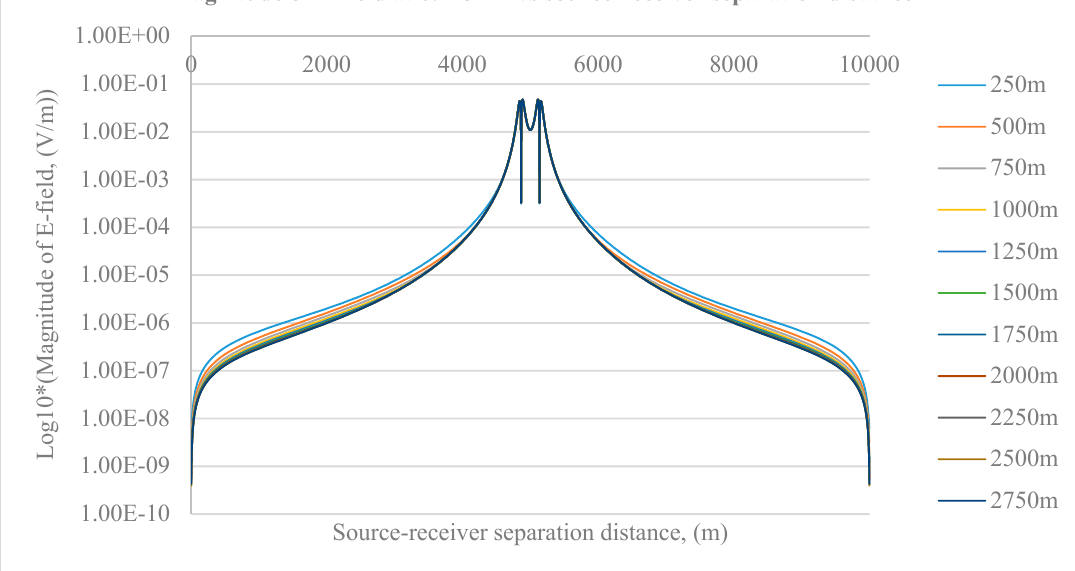
Figure 4. Log10 of magnitude of electric field at 0.125 Hz versus source–receiver separation distance (offset). Different hydrocarbon depths yield different EM responses. The offset is from 0 m (left of the SBL model) to 10,000 m (right of the SBL model).